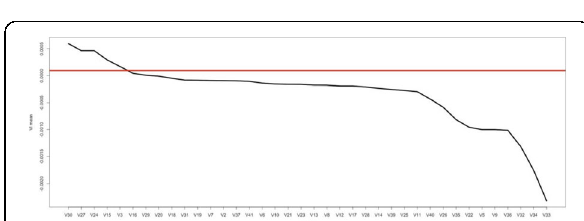
Fig. 2 (abstract P149). Multivariate analysis using random forest showing sorted variable importance (VI) mean VI (on the X-axis) of all variables recorded , in descending order (on the y-axis). The red line is the threshold value. Only five items were above the line but with minor significance, of no clinical relevance (VI mean < 0.002). Variables legend: V2: Current age, V3: Gender, V5: Age of Onset,